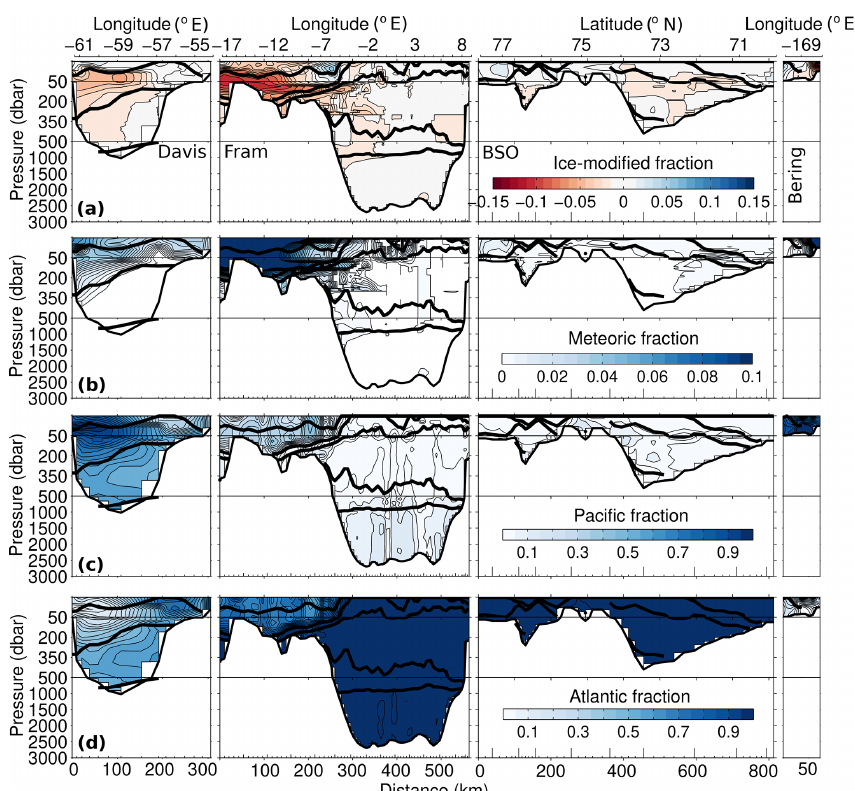
Figure 8. Sections of ice-modified water flux (a) , meteoric water flux (b) , Pacific water flux (c) and Atlantic water flux (d) , for the 4EM model (mSv), clockwise around the four gateways from Davis Strait to Bering Strait. Solid black lines indicate the isopycnal surfaces separating the main Arctic water masses as described in Tsubouchi et al. (2012). End members used were the mean of the literature values (see Tables 2 and 3). Note different colour scales for each panel. Positive values indicate flux into the